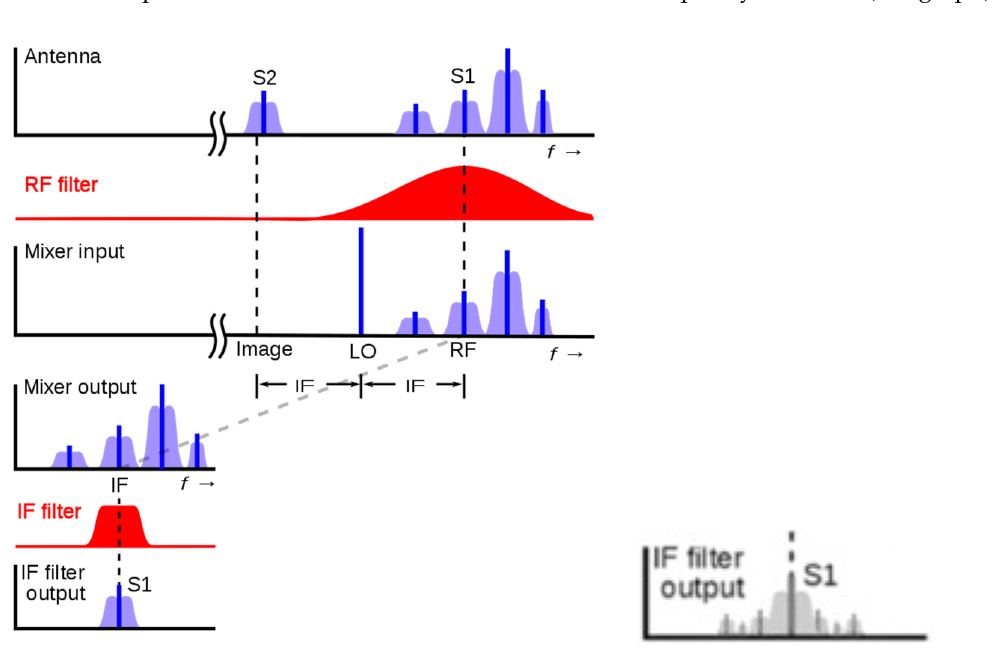
Figure 1. Basic components of a receiver.